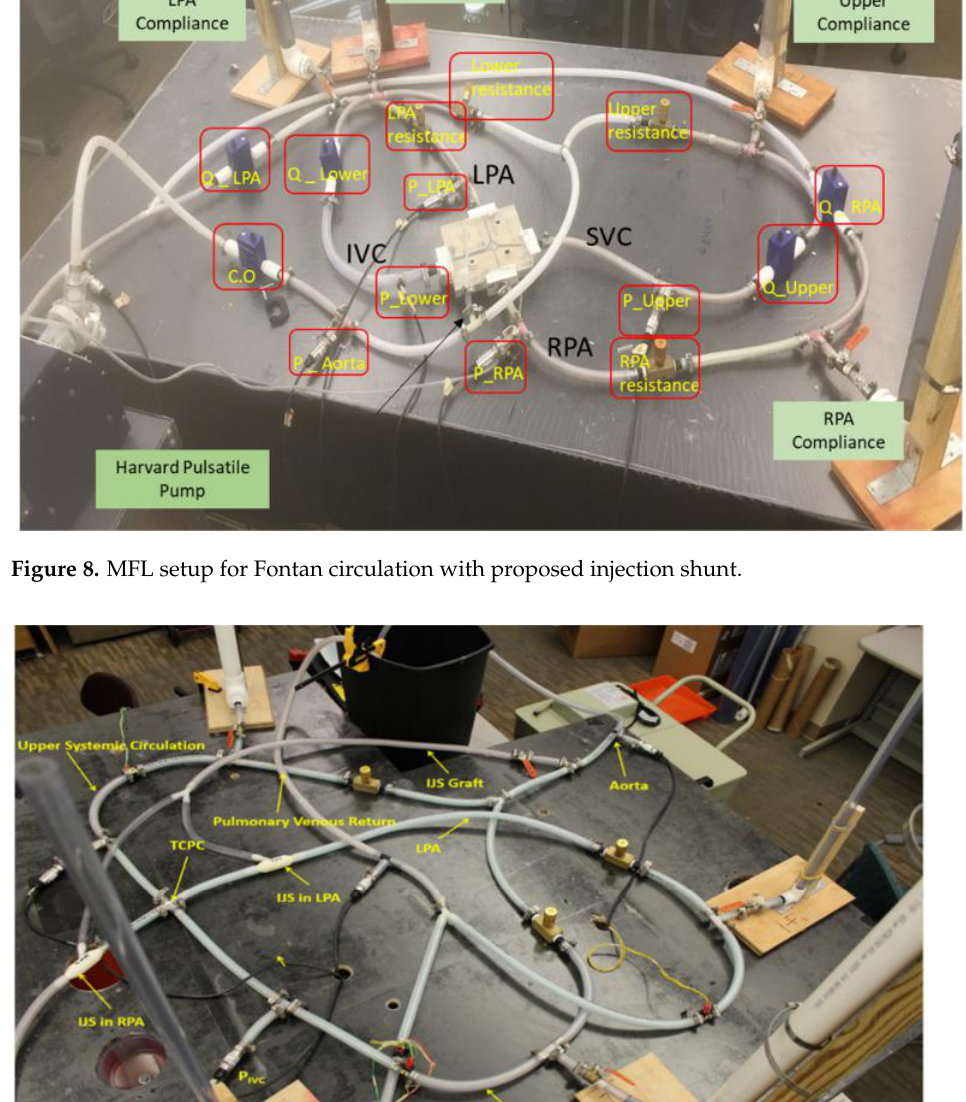
Figure 10. IJS proximal anastomosis angle. In all these experiments, the Harvard Apparatus medical pump emulates C.O and provides the pulsatile waveform to the whole MFL setup. An RPM decal of the pump determines the frequency of the stroke rate of the piston for a set stroke value. In addition, an output-to-input phase ratio determines the amount of systole to diastole ratio that should be present in each cardiac cycle for the particular stroke and RPM setting. The pulsatile pump was set to produce an output of ~2.4 L/min; this requires pump settings of 80 RPM and 30 cubic centimeters (cc) per stroke. These values were set to match non- dimensional parameters calculated from physiological data. As mentioned in the above modeling section, the vascular inductance was not modeled while developing the LPM